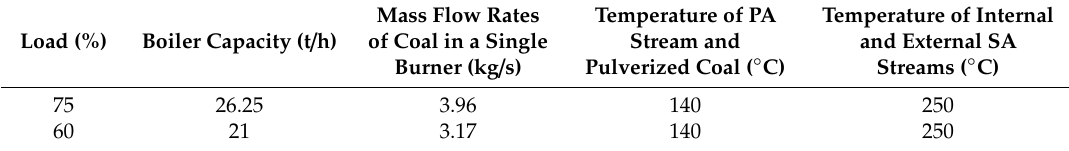
Table 2. Settings of the burner inlet